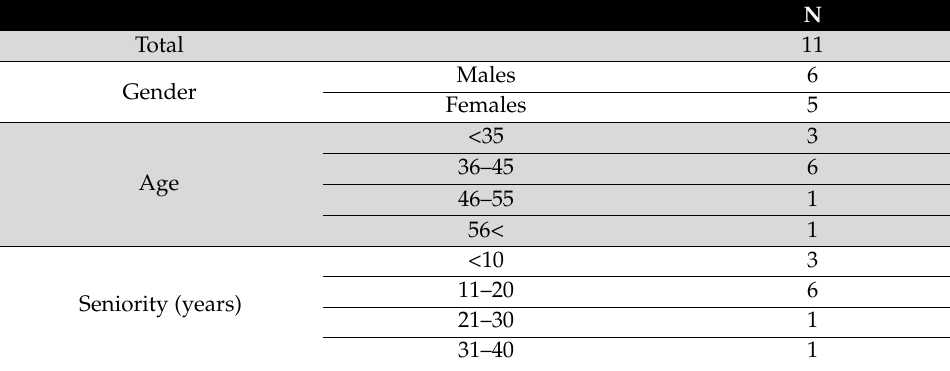
Table 1. Participant data from Rambam Hospital.